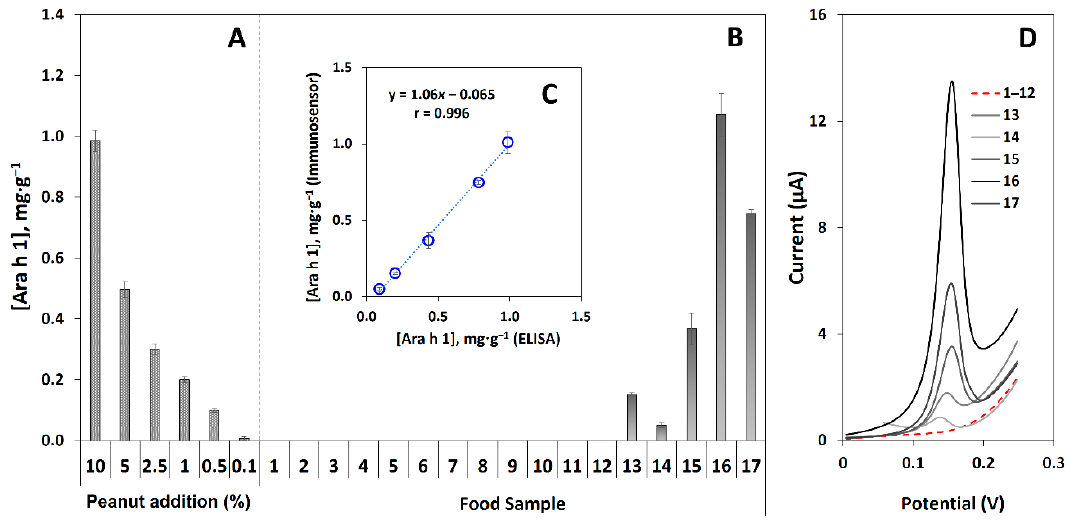
Figure 4. ( A ) Addition of decreasing amounts of peanut (10, 5.0, 2.5, 1.0, 0.50, and 0.10% ( m / m )) in a food sample (biscuit without peanuts). ( B ) Quantification (mg·g − 1 ) of Ara h 1 in food samples: 1—